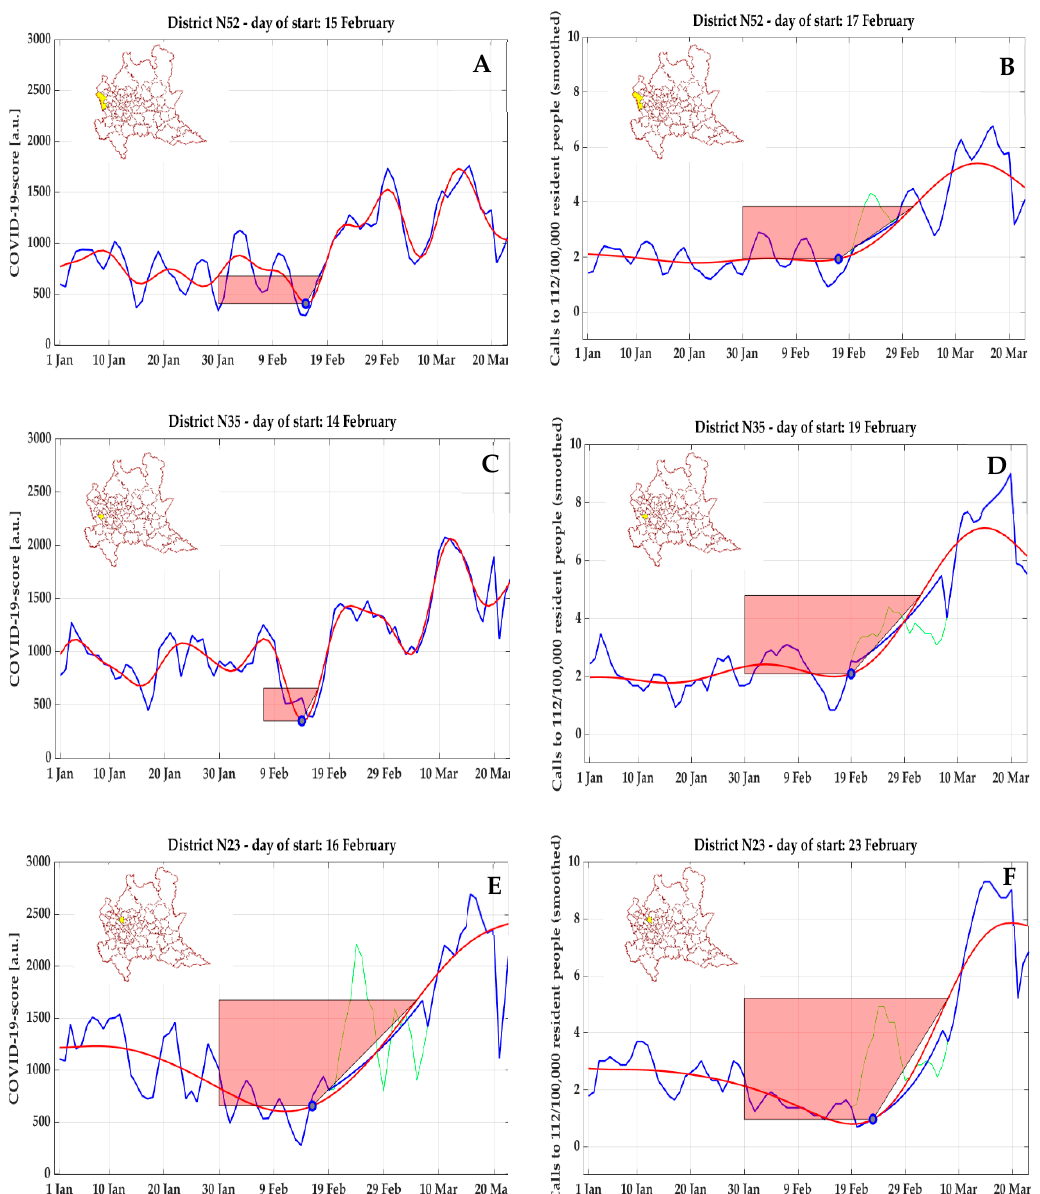
Figure 12. For the cluster including Malpensa airport (#52): ( A ) COVID-19-score time series with identified inflection point (blue dot, see text for details); ( B ) normalized emergency calls (NEC, N calls / 100,000 residents) time series with identified inflection point. For the clusters including two nearby areas, such as Parabiago (#35) and Cantù (#23), ( C , E ) COVID-19-score time series with identified inflection point (blue dot, see text for details); ( D , F ) normalized emergency calls (NEC, N calls / 100,000 residents) time series with identified inflection point. The early start date found in these three clusters according to COVID-19 score was characterized by unusual morphologies in the curves, and not confirmed by NEC time-series, which resulted in later dates.